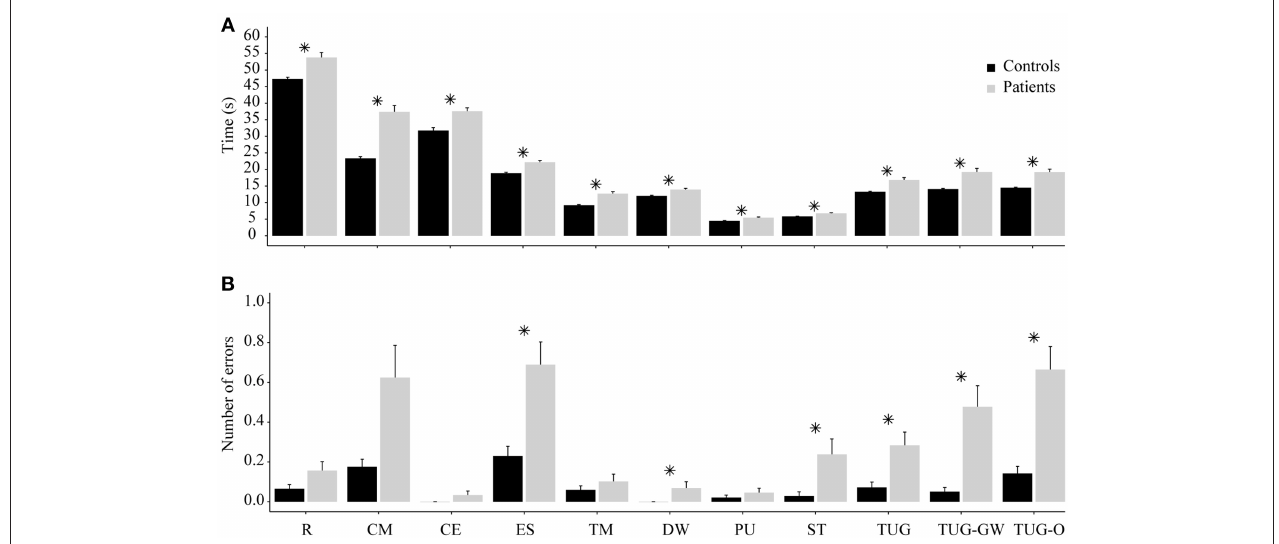
FIGURE 3 | Performance comparison between controls and patients. (A) Comparison of time required in each ADL between patients and controls. (B) Corresponding errors made in each ADL between patients and controls. R, Reading ; CM, Counting money ; CE, Cutting-eating ; ES, Eating soup ; TM, Taking medication ; DW, Drinking water ; PU, Pick-up an object ; ST, Sitting-standing ; *means statistically significant; error bars correspond to standard error.